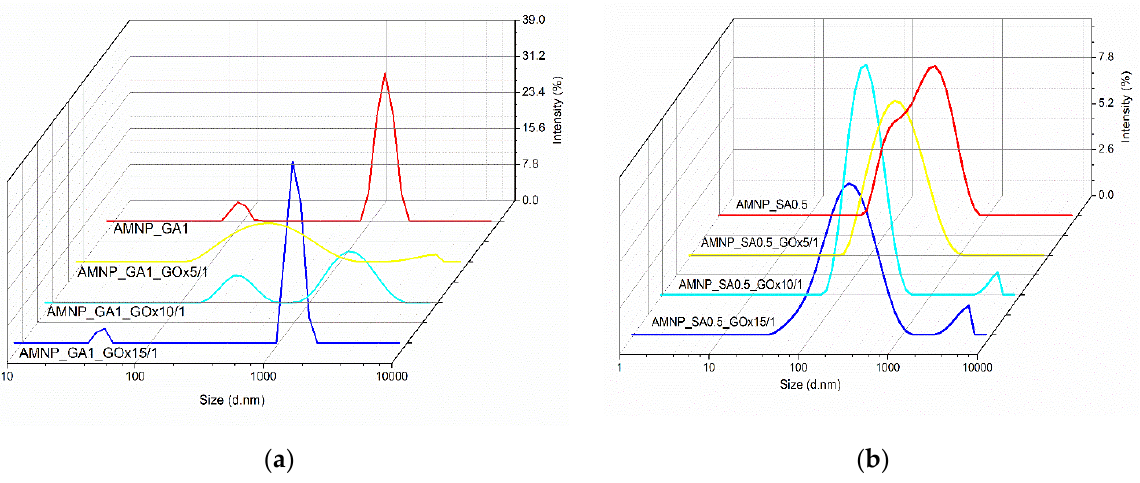
Figure 4. Size distribution reported to the nanoparticles/enzyme mass ratio ( a ) AMNP_GA1 and ( b ) AMNP_SA0.5 in buffer, 0.01M, pH 6.5 and room temperature.